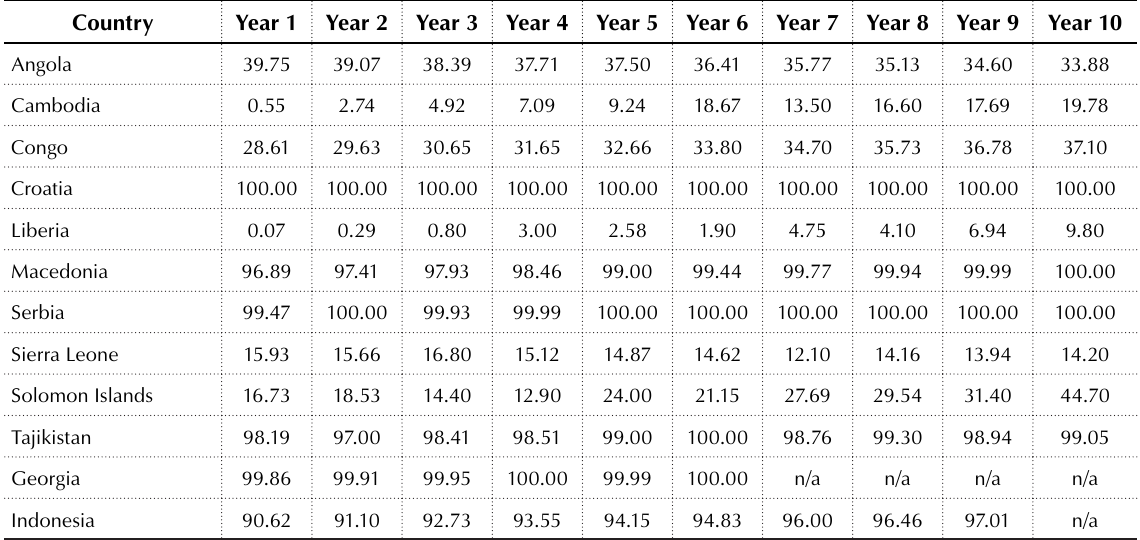
Table 1. Access to electricity in selected post-conflict countries, % of population